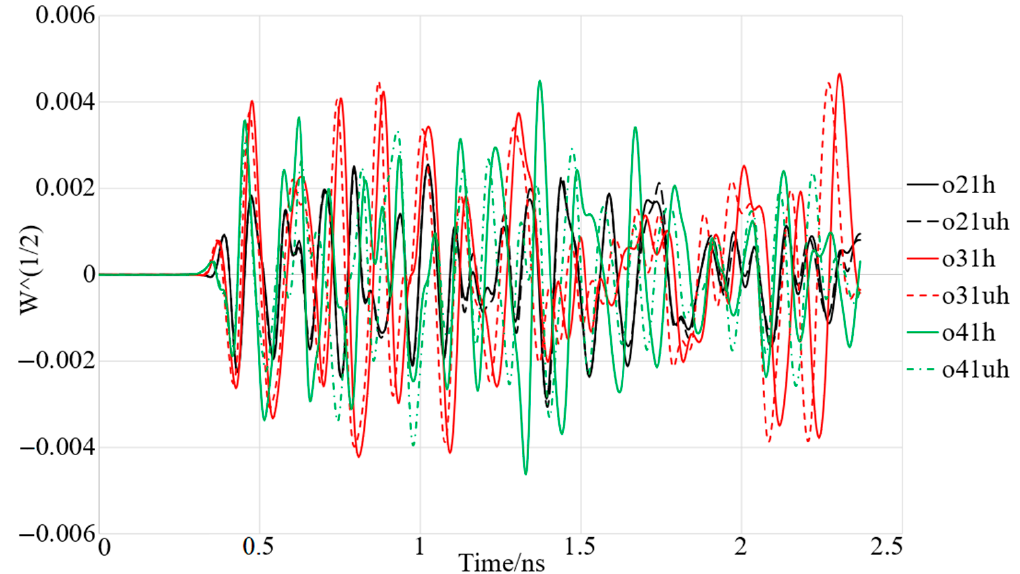
Figure 10. Simulated setup of the antenna array elements in on-body conditions (with (uh) and without (h) tumour).